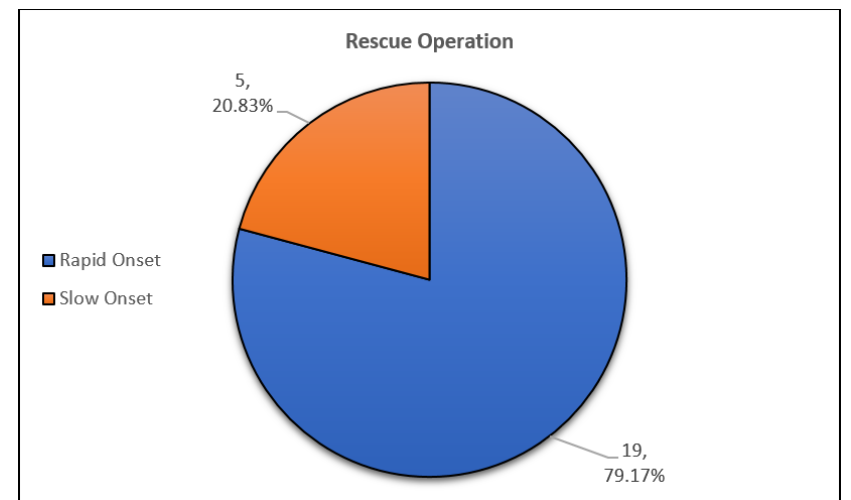
Figure 13. Breakdown of VRP for Rescue Operation based on Disaster Type.